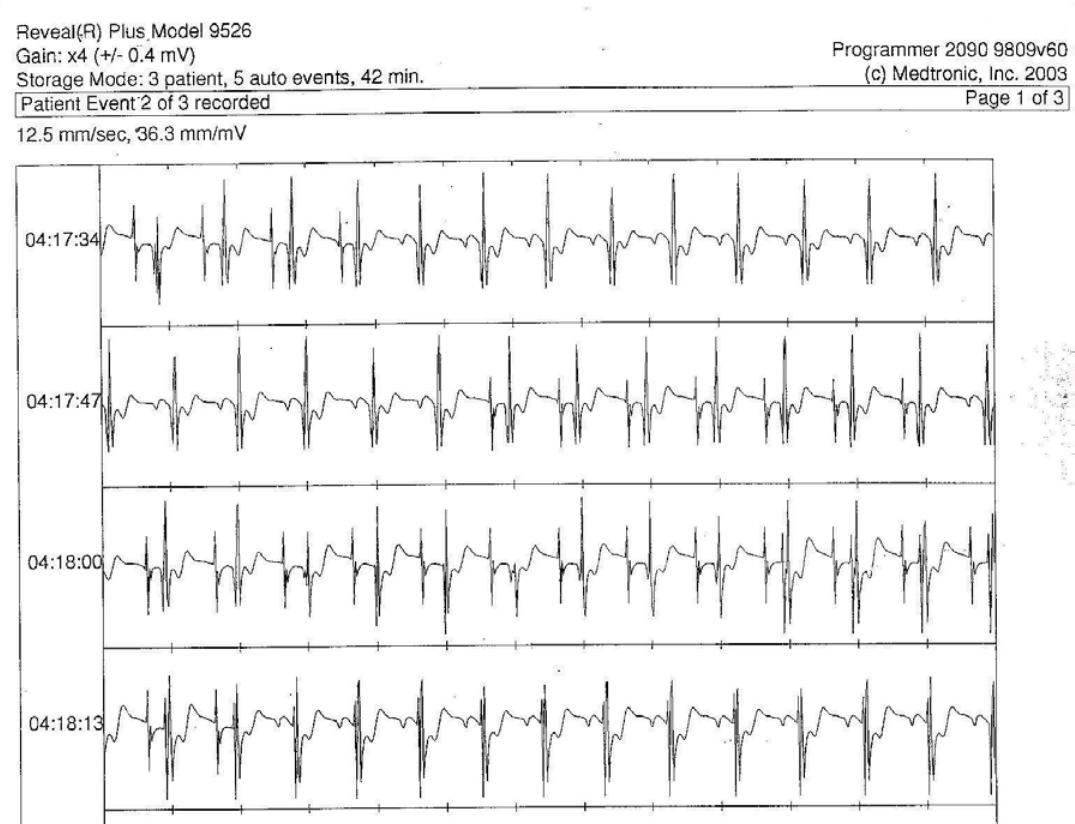
Figure 2. Implantable loop recording during syncopal episode after cardiac pacemaker